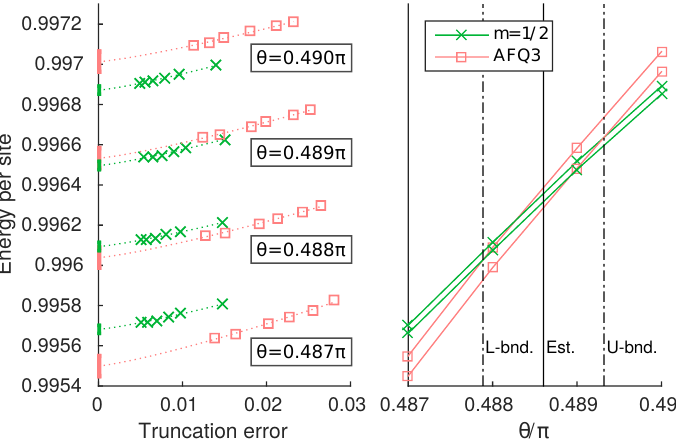
Figure 9: The phase transition between the AFQ3 and m = 1 / 2 phases. Left: energy per site for bond dimensions D = 5,6,...,10 as a function of truncation error, which we extrapolate to zero. Right: extrapolated energy per site as a function of θ . We estimate the phase transition to occur at the point where the energies per site intersect, i.e. at θ = 0.4886 ( 7 ) π .